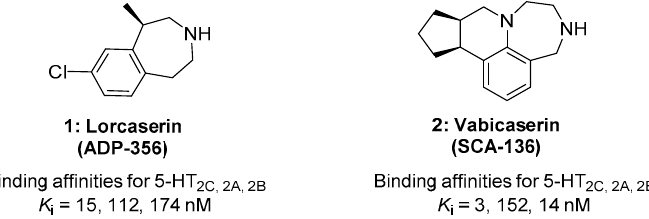
Figure 1. The chemical structures of representative 5-HT 2C receptor ligands and their binding affinities for 5-HT 2 receptor subtypes [19,21].